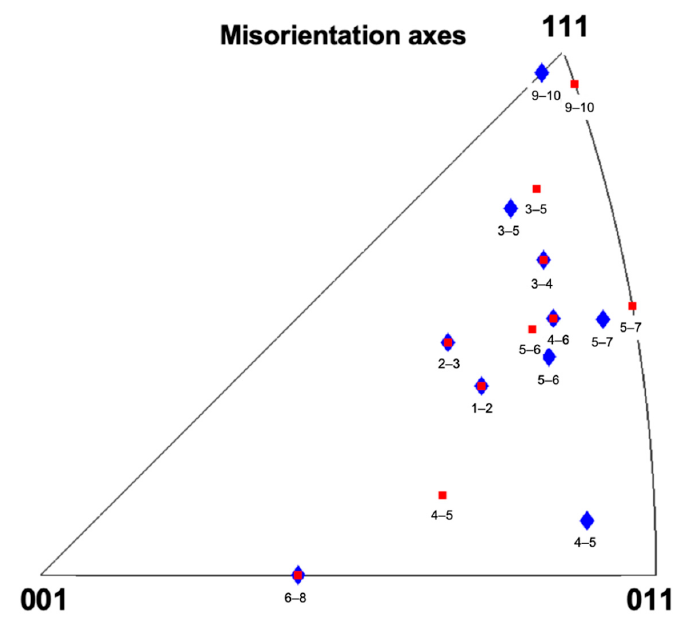
Figure 9. Misorientation axis represented in an IPF before and after deformation, denoted by blue and red markers.